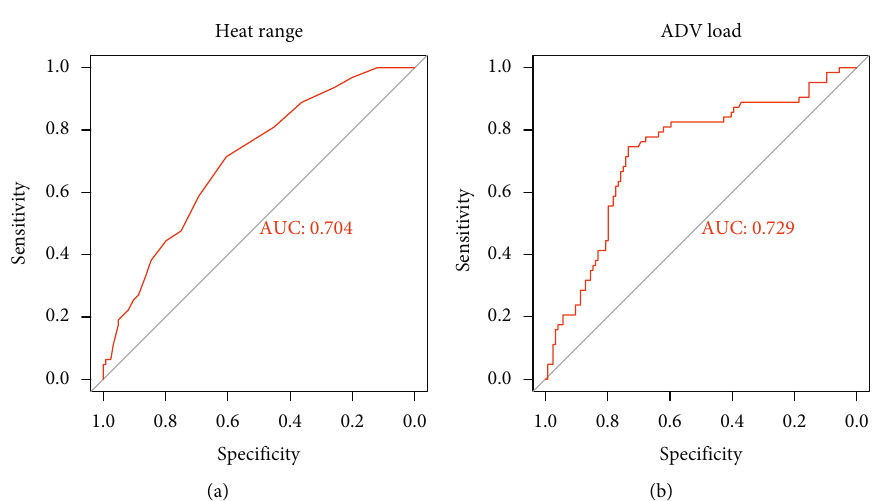
Figure 3: ROC curve analysis of patients with a single AdV infection. (a, b) The heat range and AdV load in the ROC curve predicted the sensitivity and specificity of single AdV pneumonia BMP formation at 71.4% and 60.5% and 74.6% and 73.4%, respectively.